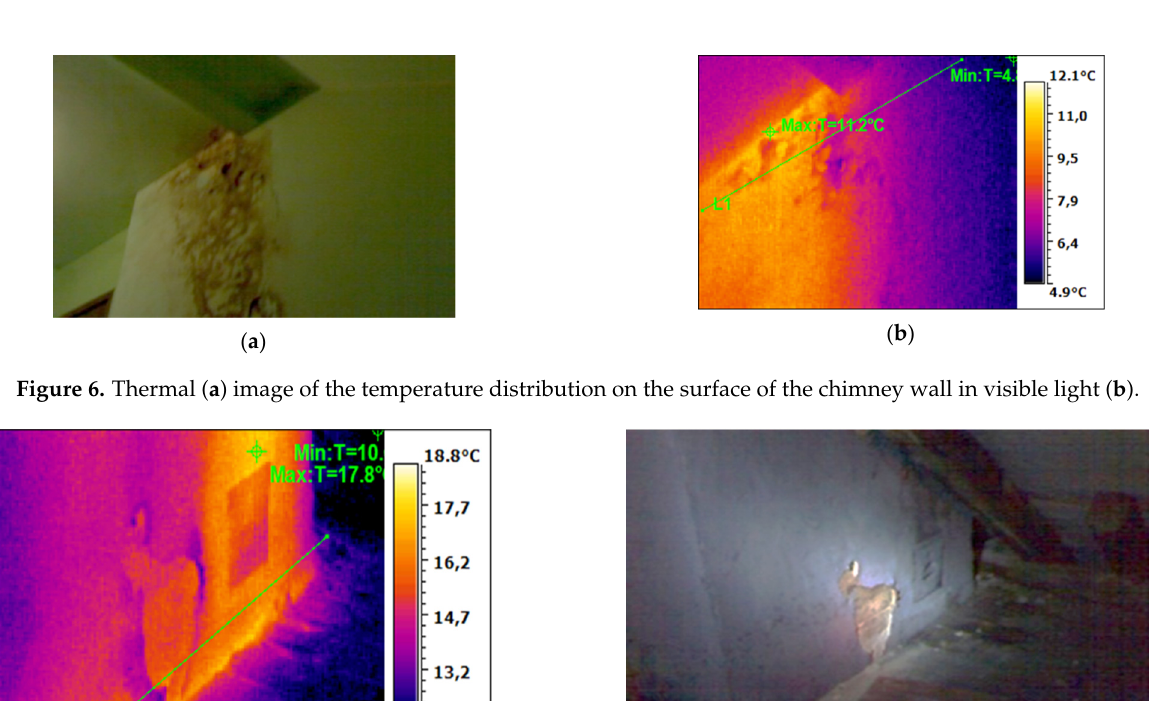
Figure 5. Consequences of inadequate protection of external and internal chimney walls ( a , b ) elevation, ( c ) inside. This can lead to serious mechanical damage to chimneys and even entire buildings. The variation of the temperature fields on the chimney wall is shown in Figures 6 and 7, diagrams of temperature distribution (along the line running directly under the ceiling).